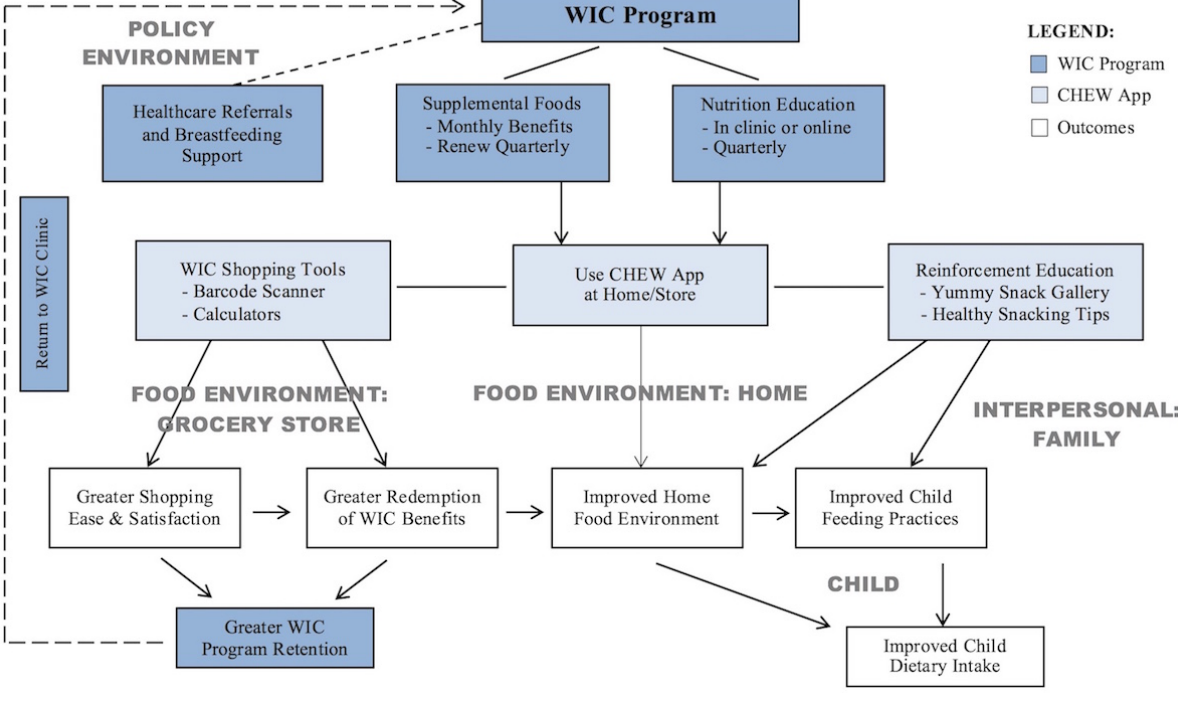
Hull et alJMIR MHEALTH AND